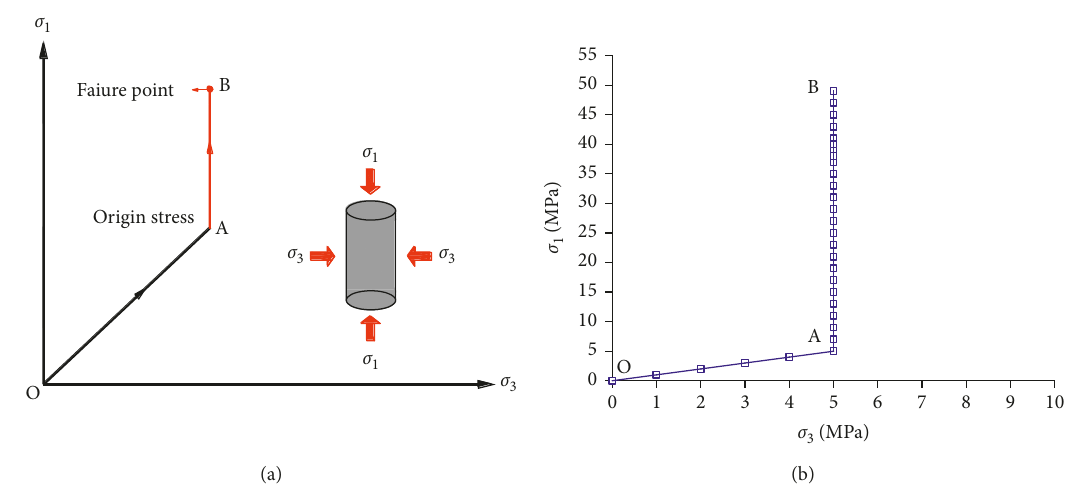
Figure 5: Triaxial experimental stress path. (a) Designed stress path. (b) Experimental stress